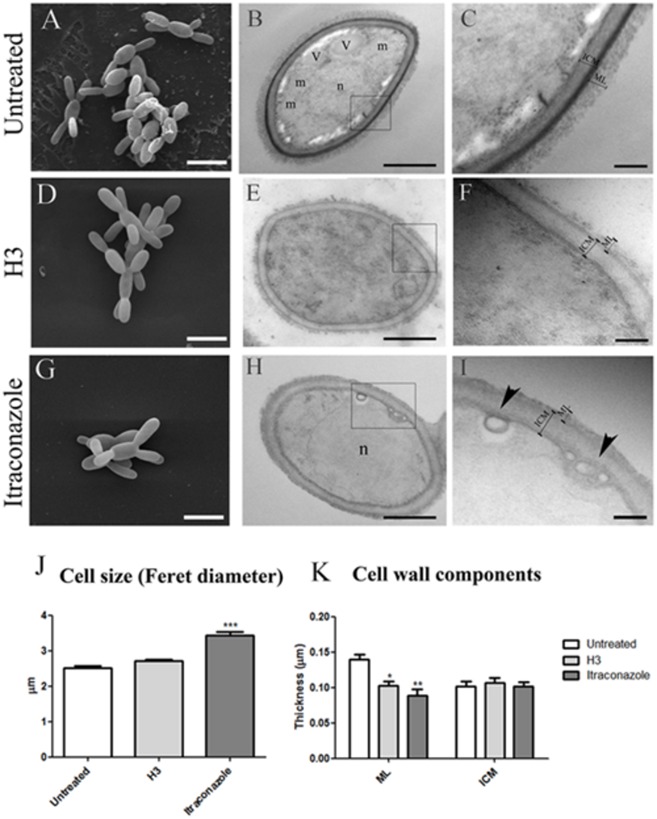
Ultrastructural analysis of Sporothrix brasiliensis ATCC MYA 4823 cells after exposure to 0.03 mg/L H3 (D–F) or 0.25 mg/L itraconazole (G–I) compared to untreated cells (A–C). Scanning electron microscopy (A,D,G) and transmission electron microscopy (B,C,E,F,H,I) images show the presence of: m, mitochondria (B); n, nucleus (B,H); v, vacuole (B); inner cell wall (ICW); microfibrillar cell wall layer (ML). Arrowheads indicate small vesicles associated with the plasma membrane (I). (J) Cell diameter analysis by calculation of Feret diameters. (K) Analysis of ICW and ML thickness as measured in TEM images. ∗p < 0.05, ∗∗p < 0.001, ∗∗∗p < 0.0001. Scale bars: 5 μm (A,D,G); 0.5 μm (B,E,H); 0.2 μm (C,F,I).